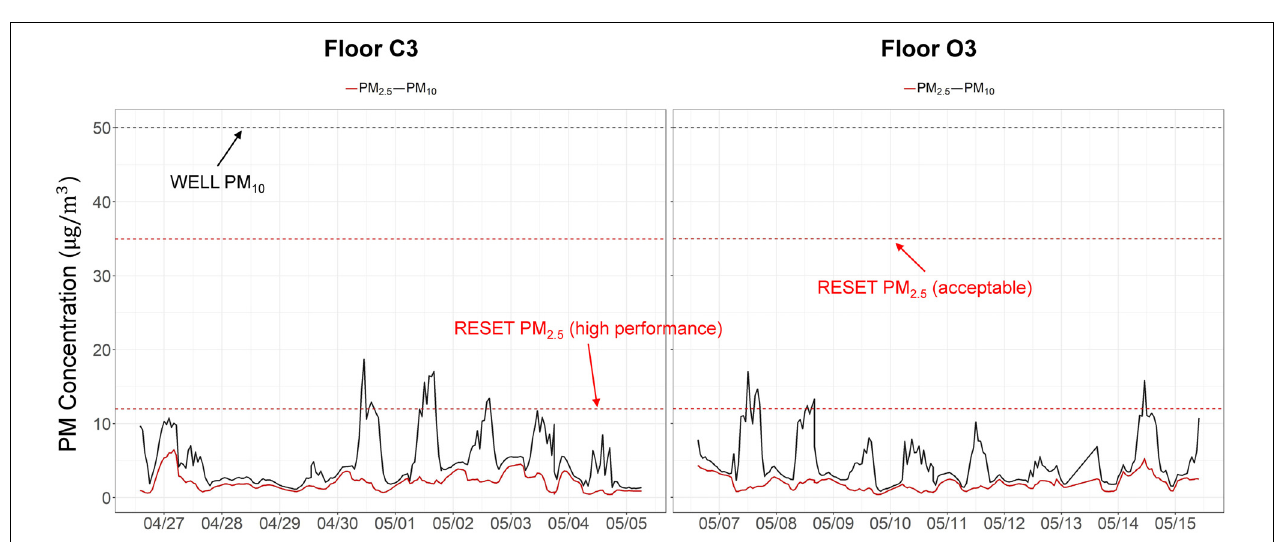
FIGURE 7 | Post-retrofit PM 2 . 5 and PM 10 levels on C3 and O3 during normal days.